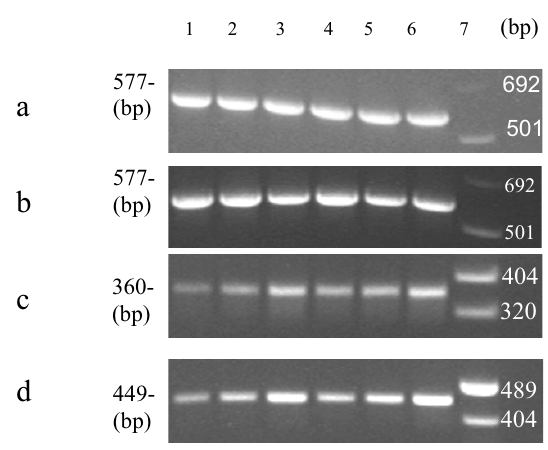
Figure 1 PCR products analysis of type I and type III collagen samples and β -actin optimisation. 1, 2 and 3) controls; 4, 5 and 6) inguinal hernias; 7) standard marker, a) β -actin amplification with annealing temperature at 60 ° C of type I collagen; b) β -